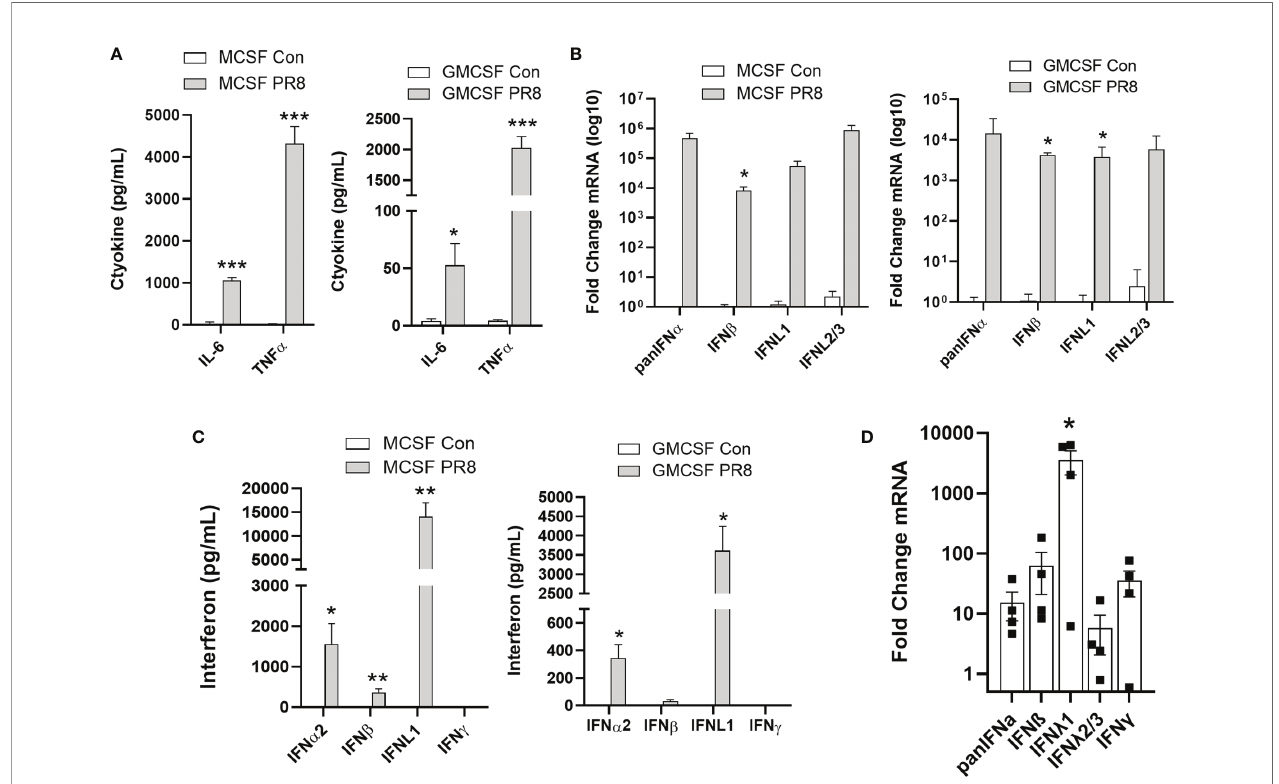
FIGURE 4 | In fl uenza infection of human macrophages leads to the production of lambda interferons. CD14 monocytes were differentiated to macrophages with M-CSF or GM-CSF (50 ng/mL, 7 days). In fl ammatory cytokines were measured at 24h post infection in M-CSF or GM-CSF macrophages infected with in fl uenza PR8 (MOI=0.1) by multiplex ELISA (V-PLEX Proin fl ammatory Panel 1 Human Kit, MSD). Only IL-6 and TNF a were signi fi cantly altered by in fl uenza infection. n= 2 experiments, n= 6 samples per group (A) . The induction of interferon mRNAs in M-CSF and GM-CSF treated macrophages was measured by qRT-PCR. (B) and secreted interferons were assayed by multiplex ELISA (U-PLEX Interferon Combo, MSD) (C) . n= 2-3 independent experiments, at least n= 6 samples per group (B, C) . The induction of interferon mRNAs in HAMs in response to PR8 was measured by qRT-PCR. Samples from 3 donor lungs, n=4 per group (D) . Multiple T-test with Holm-Sidak correction (A – D) *p < 0.05, **p < 0.01, ***p < 0.001 vs. Control (A – C) *p < 0.05 vs. IFN a (D)